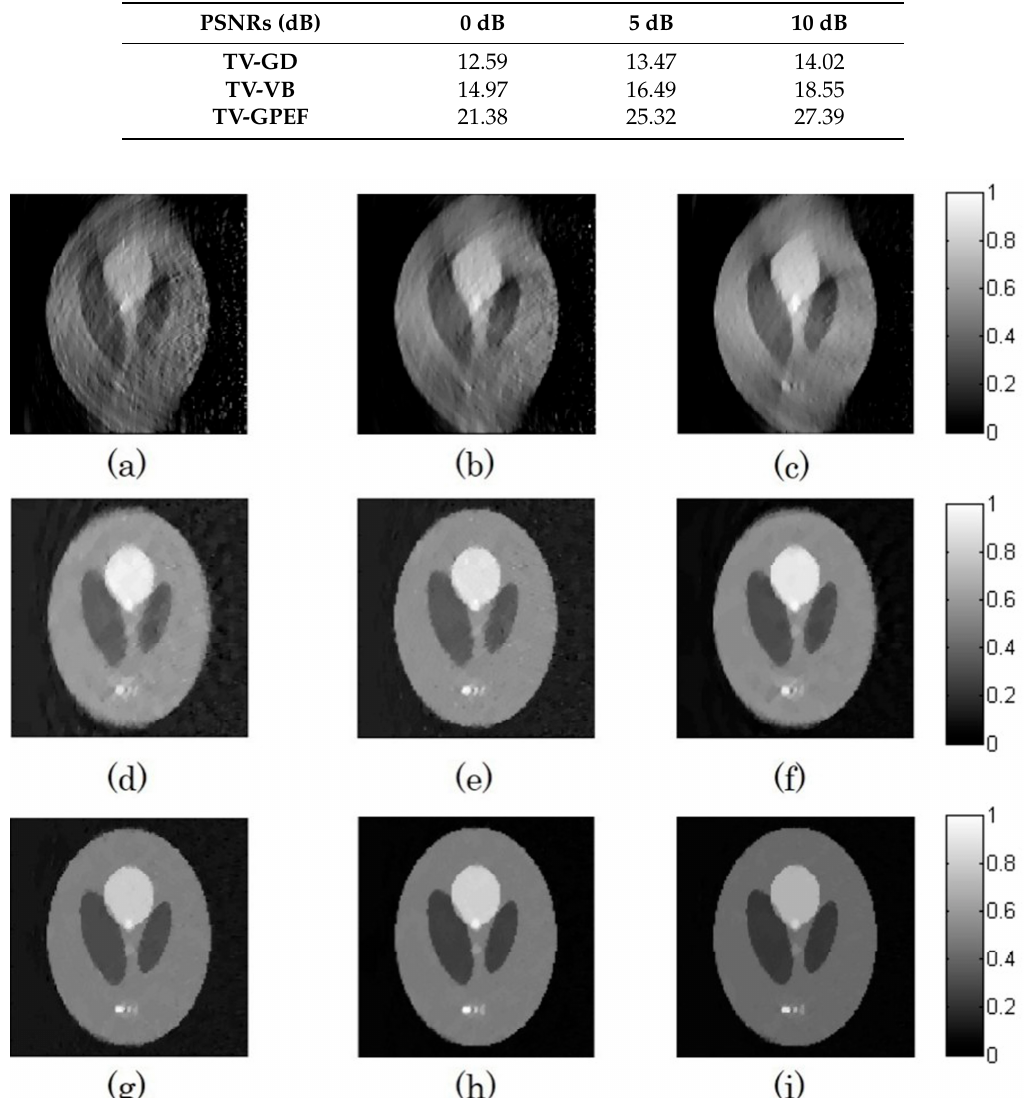
Figure 9. The reconstructed images from the noise-added signals by the TV-GD, TV-VB and TV-GPEF algorithms: the first row refers to the results of the TV-GD ( a – c ); the second row refers to the results of the TV-VB ( d – f ); and the third row refers to the results of the TV-GPEF ( g – i ). The first to third columns refer to the results from SNR of: 10 dB ( a , d , g ); 5 dB ( b , e , h ); and 0 dB ( c , f , i ) sampling,